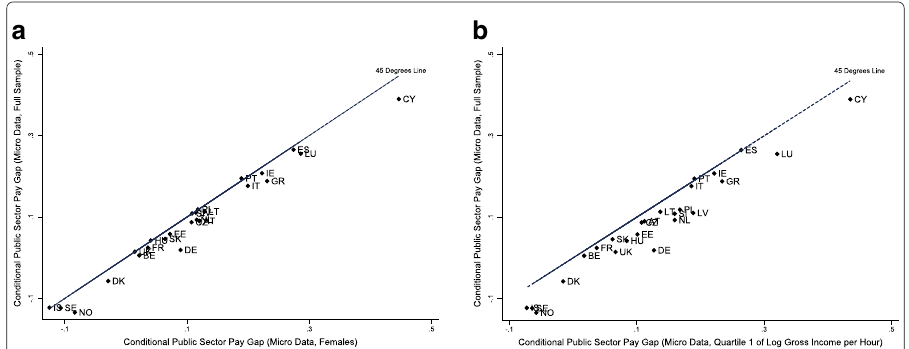
Fig. 5 Public-private pay differentials of women and low-income workers and comparison with overall pay gaps. Notes: Panel a compares the public sector pay gap conditional on observed worker characteristics (EU-SILC, see Eq. (1)) of the full sample and the sample of female workers. Panel b compares the pay gap of the full sample with that of workers at the first quartile of the income distribution. The gap of female workers is computed by estimating Eq. (1) for the sample of female workers. The gap of low-income workers is computed via a quantile regression with the same covariates as in Eq. (1). In almost all the countries, the gaps of women and low-income workers are larger than that of the full sample. Nevertheless, the cross-country differences